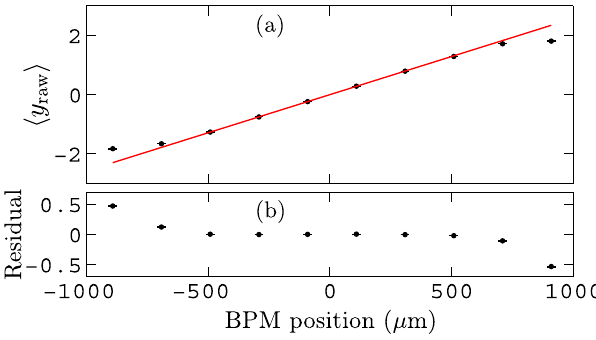
FIG. 20. (a) y vs vertical BPM position. 50 beam pulses raw are averaged at each setting; the red line is a linear fit to the central four data points. (b) Residual of the data with respect to the fitted line. The maximum deviation of the residuals corres- ponds to ∼ 200 μ m at the extremal points, clearly showing the effect of saturation in the mixers when operated outside of their linear